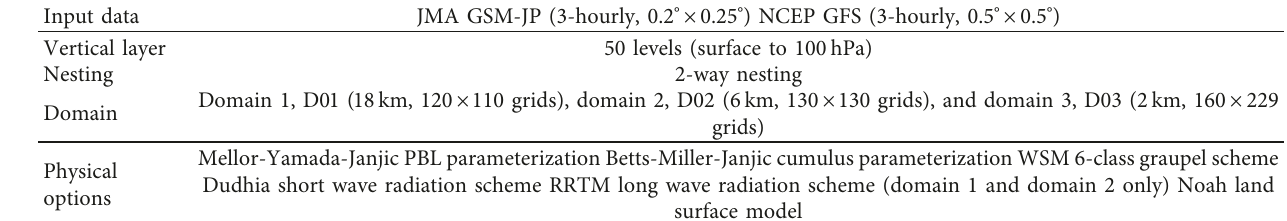
Table 1: Configuration of the WRF model.